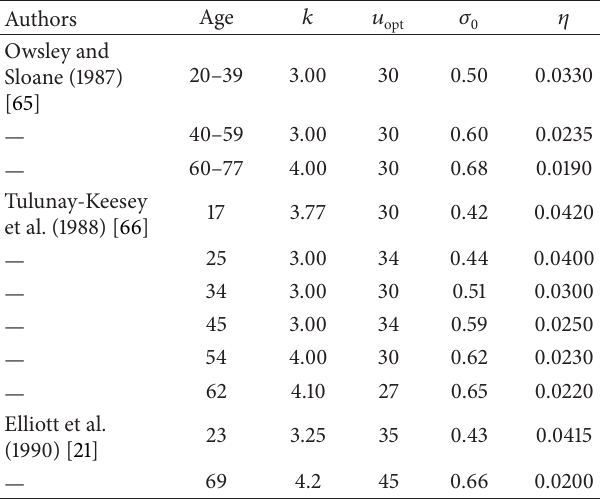
Table 1: Estimates of the CSF model’s parameters. Age is in years, 𝐿 in cpd, 𝜎 0 in arcmin, and 𝜂 in %. in cd/m 2 , 𝑢 opt